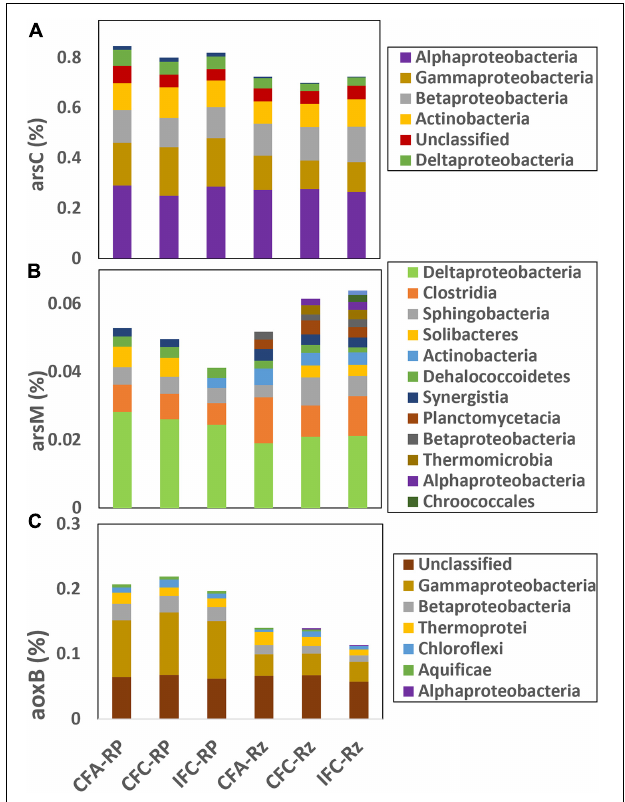
FIGURE 2 | Relative abundance of major taxonomic classes represented within different arsenic cycling gene probes (A) arsC, (B) arsM and (c) aoxB in the rhizosphere compartments under different soil As and water management treatments. CFA, continuously flooded-arsenic; CFC, continuously flooded-control; IFC, intermittently flooded control. Suffix RP and Rz in group labels represent the root-plaque and the rhizosphere samples, respectively.